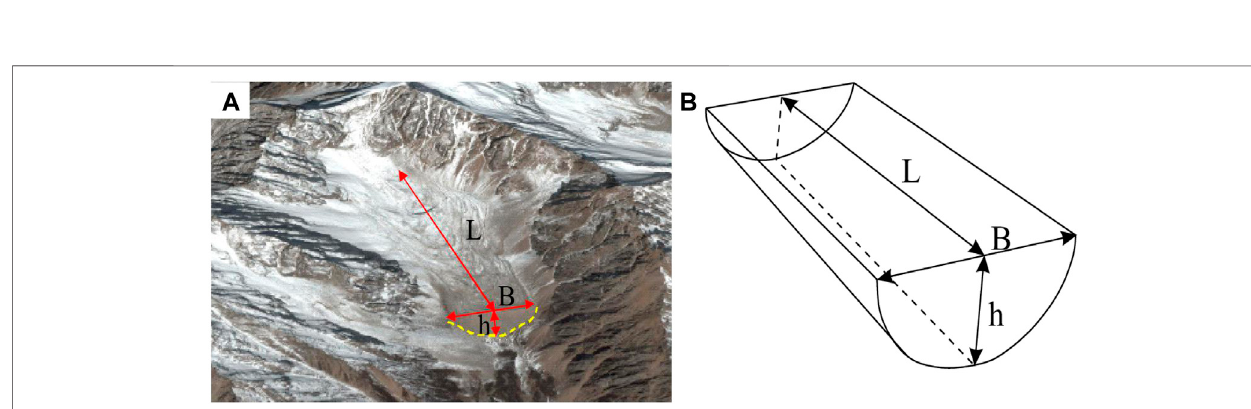
FIGURE7| Theaccumulationmorphologyandgeometricmodelofmorainesintroughvalleyandcirque. (A) Googleearthimage. (B) Correspondingsketchmodel.